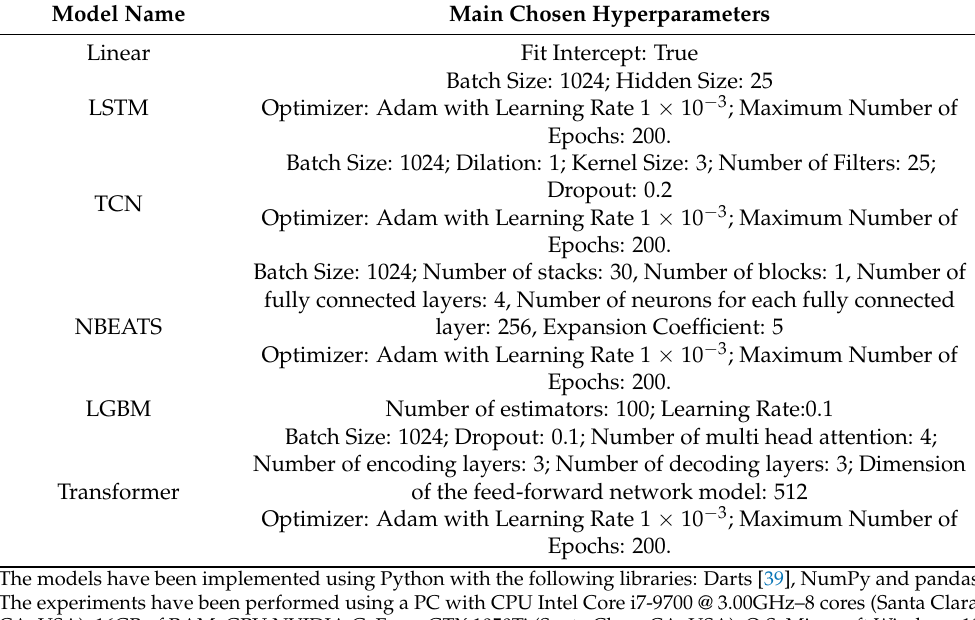
Table 1. Main parameters chosen for the considered